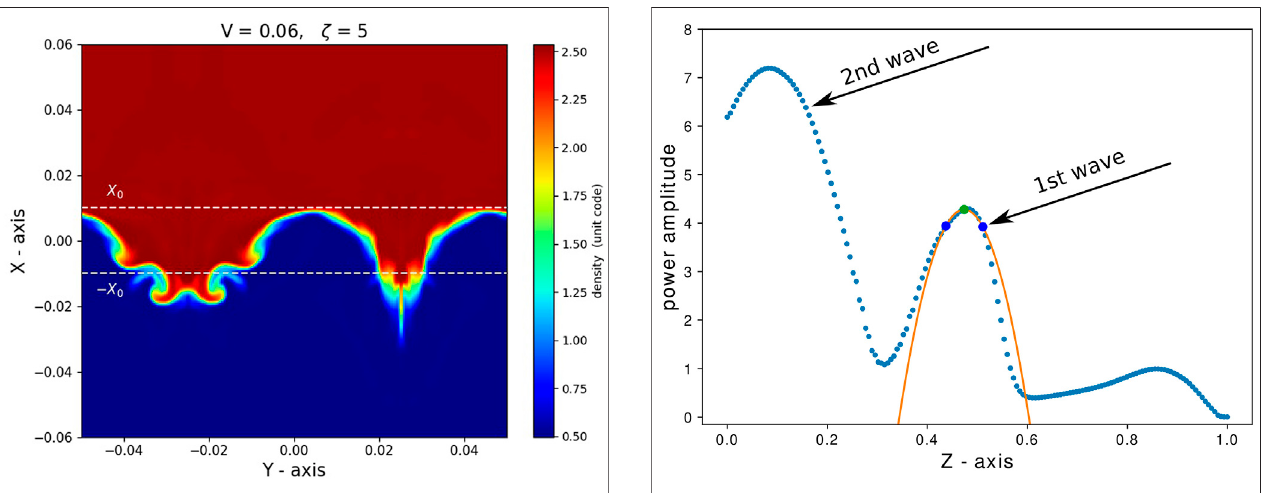
FIGURE 3 | Graph shows one snapshot of the region for the Fourier analysis of the v x ( y , z , t ) slices.